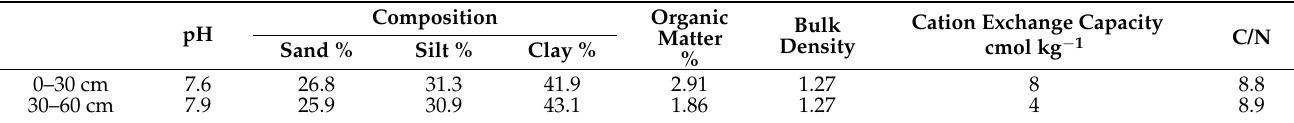
Table 5. Soil properties of surface (0–30 cm) and sub-surface horizons (30–60